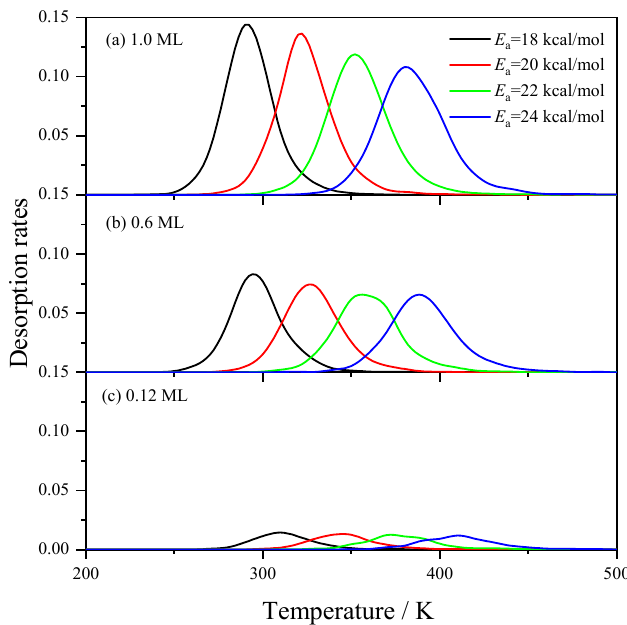
Figure 5. Effects of the H(a) desorption barrier on the H 2 TDS spectra. v = 10 13 s − 1 , E int = 0 kcal/mol.